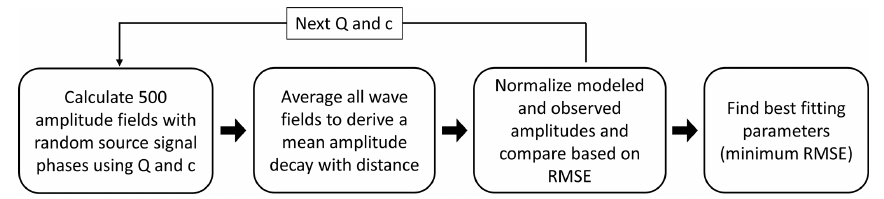
Figure 9. Description of the fitting process to find the best model parameters from the comparison of calculated and observed amplitudes.